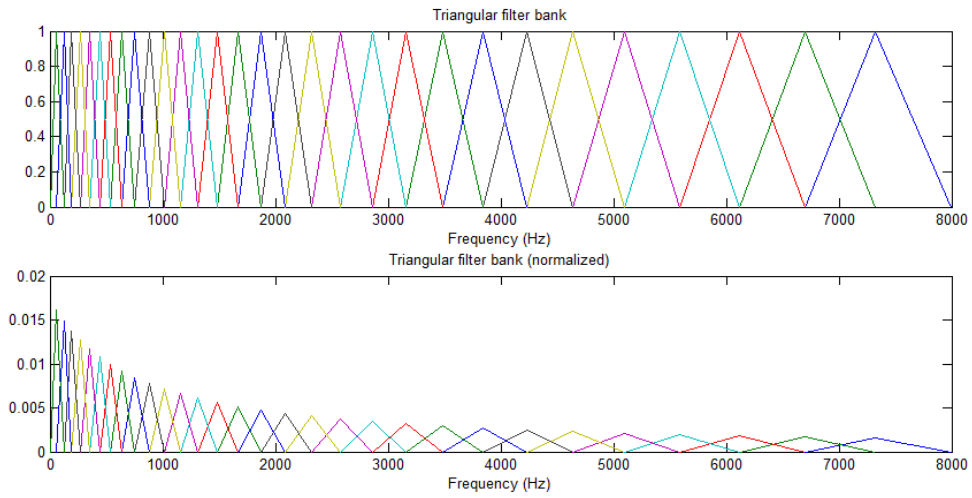
Figure 16. Triangle of band-pass filter in